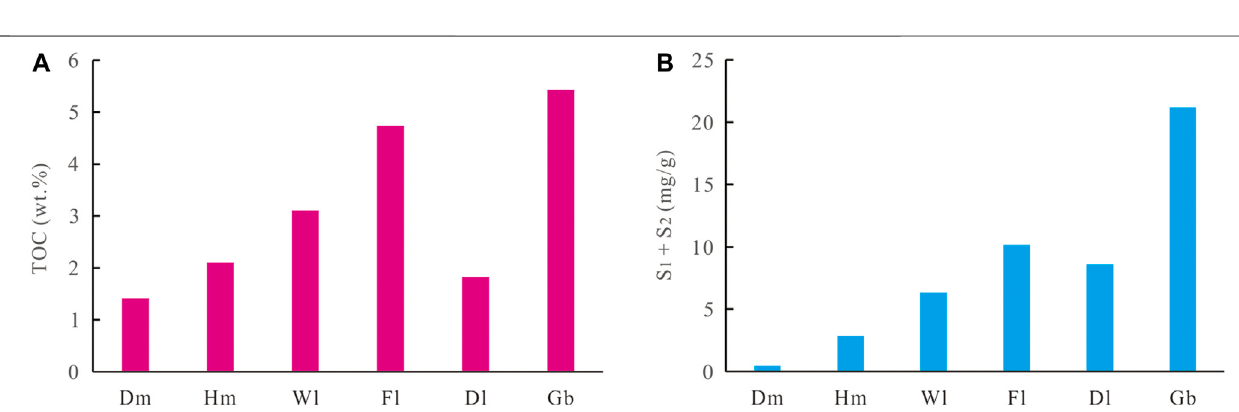
Frontiers in Earth Science |